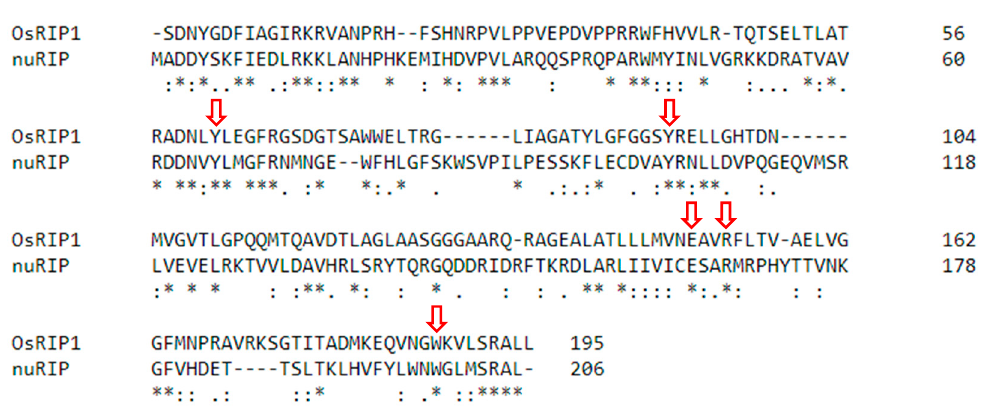
Figure 1. Alignment between the amino acid residues from ribosome-inactivating protein (RIP) domains of OsRIP1 and nuRIP. Red arrows point towards the active site residues for the RIP domain. Asterisks refer to residues that are fully conserved, colons indicate residues with highly similar properties, dots indicate residues with weakly similar properties.